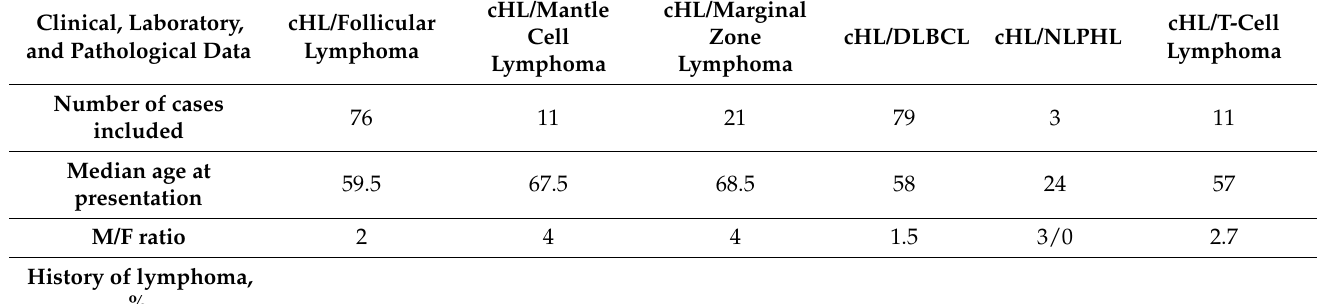
Table 1. Clinical, laboratory, and pathological